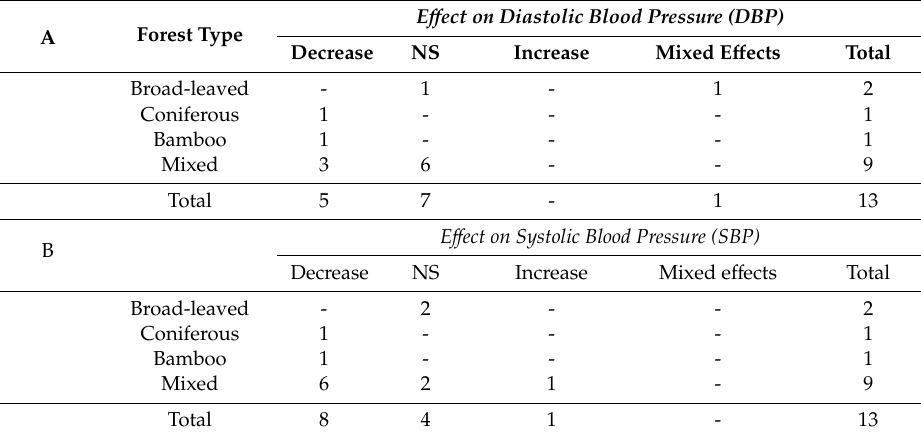
Table 2. E ff ects of forest type on blood pressure in the before-after studies. (A) diastolic blood pressure